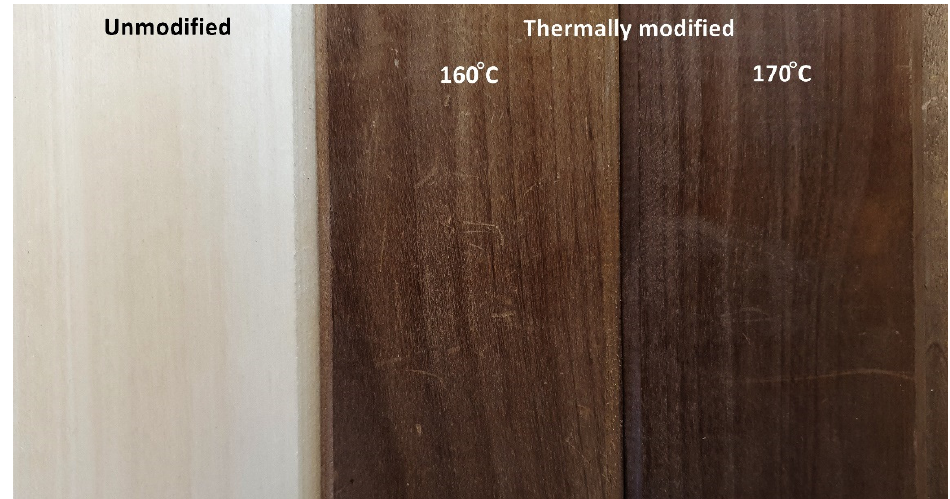
Figure 1. Unmodified and thermally modified aspen wood.